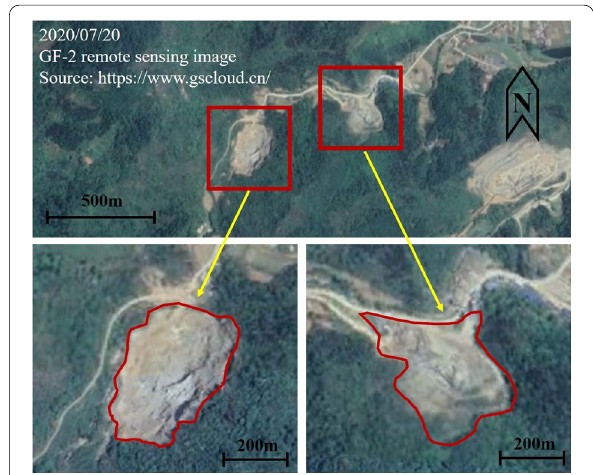
Fig. 2 The preparation process of landslide inventory map